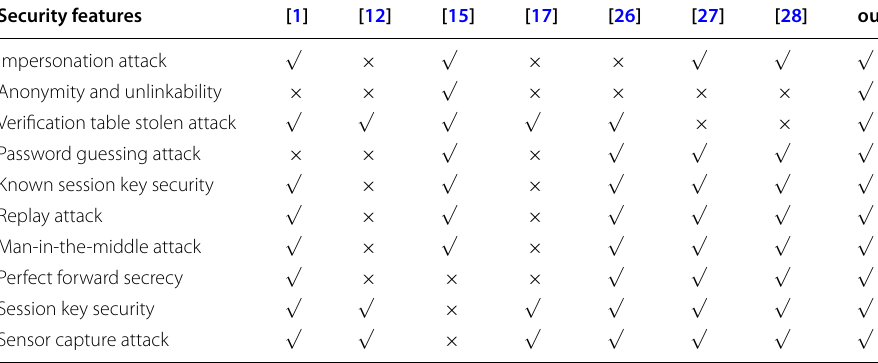
Table 8 Comparison of security features Security features